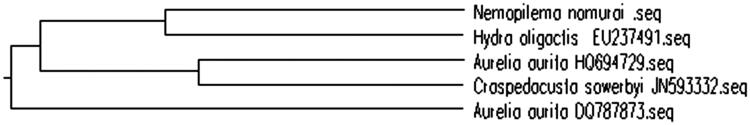
Phylogenetic relationship revealed by NJ tree.